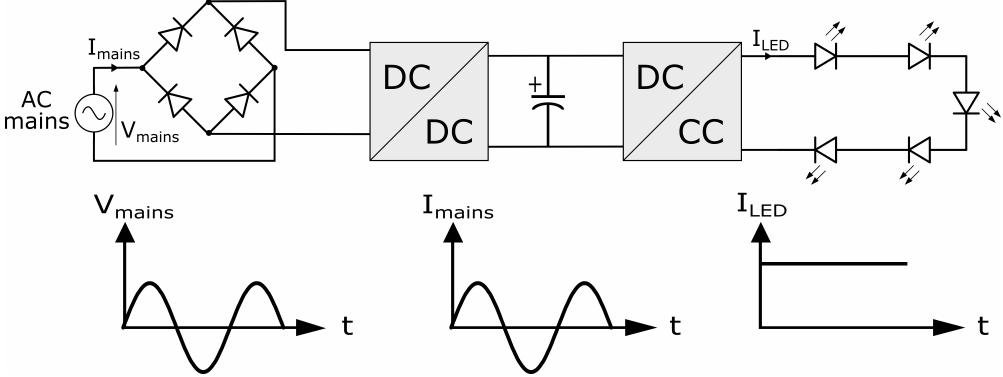
Figure 4. A boost-buck AC LED driver. The bridge rectifier and first DC/DC converter act as a boost stage, functioning as a power factor corrector (PFC). The second stage functions as a constant current source for the